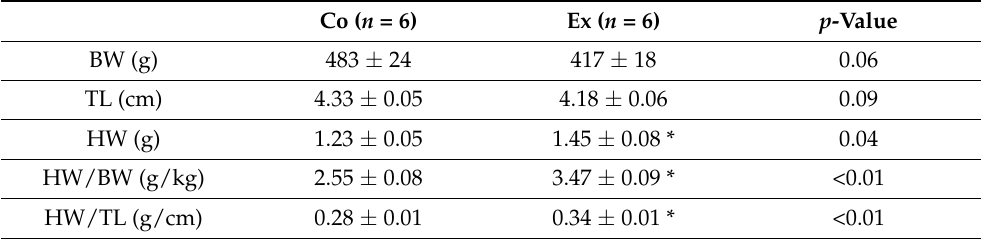
Table 1. Body and heart weight